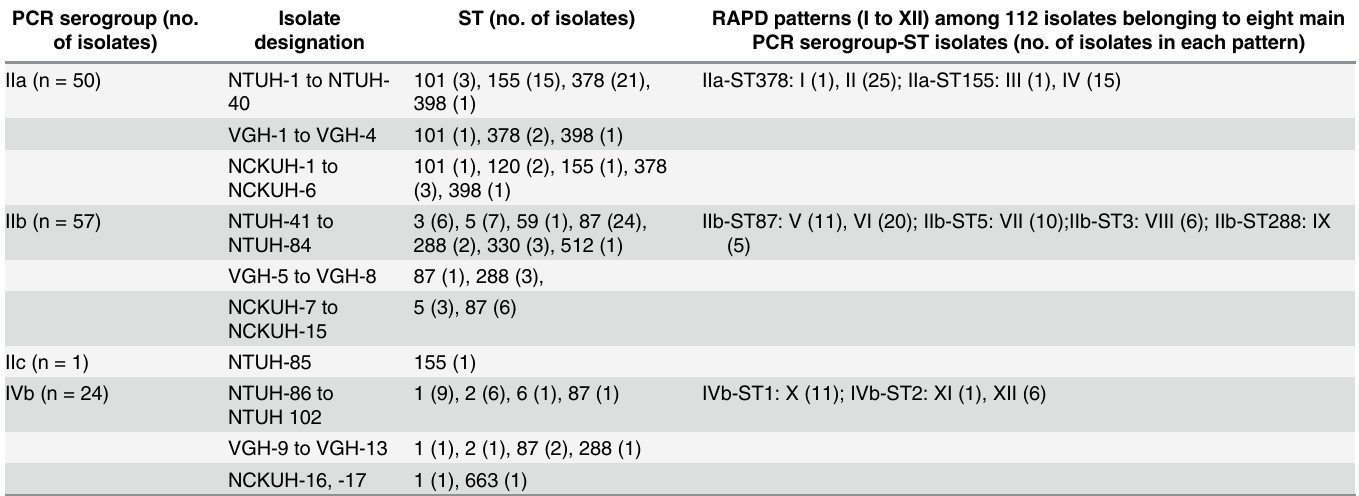
Table 2. PCR serogroups, sequence type (ST), and randomly amplified polymorphic DNA (RAPD) patterns generated by arbitrarily primed PCR (AP-PCR) of main PCR serogroup-ST isolates (number of isolates (cid:1) 5) of 132 isolates collected from three medical centers in Taiwan, 2000 – 2013. PCR serogroup (no. of isolates)